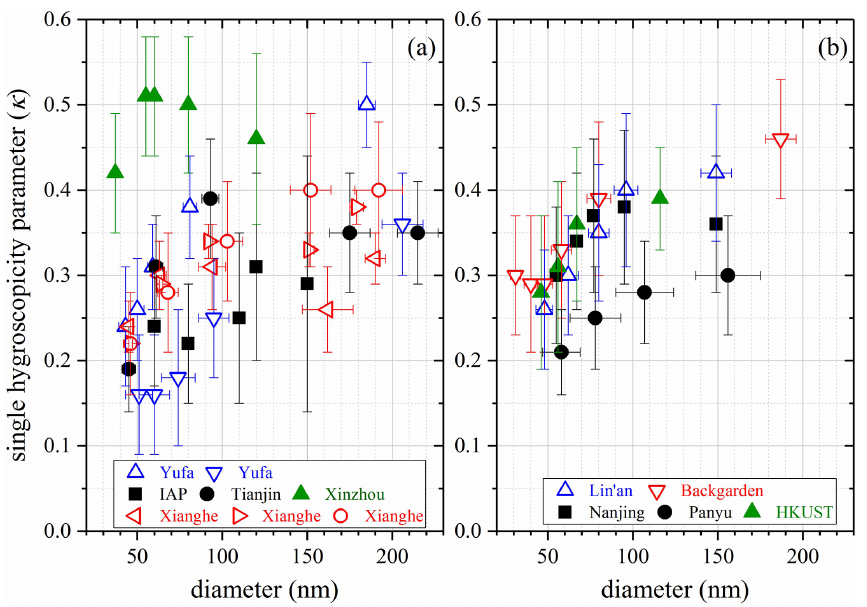
Figure 7. Measured κ a as a function of particle diameter reported by previous studies (Rose et al., 2010; Deng et al., 2011; Gunthe et al., 2011; Deng et al., 2013; Meng et al., 2014; Zhang et al., 2014; Che et al., 2016; Ma et al., 2016; Che et al., 2017; Ma et al., 2017; Zhang et al., 2017; Cai et al., 2018; Tao et al., 2020) in the NCP (a) and other regions in China (b) . Solid symbols represent urban and suburban sites, and open symbols represent rural